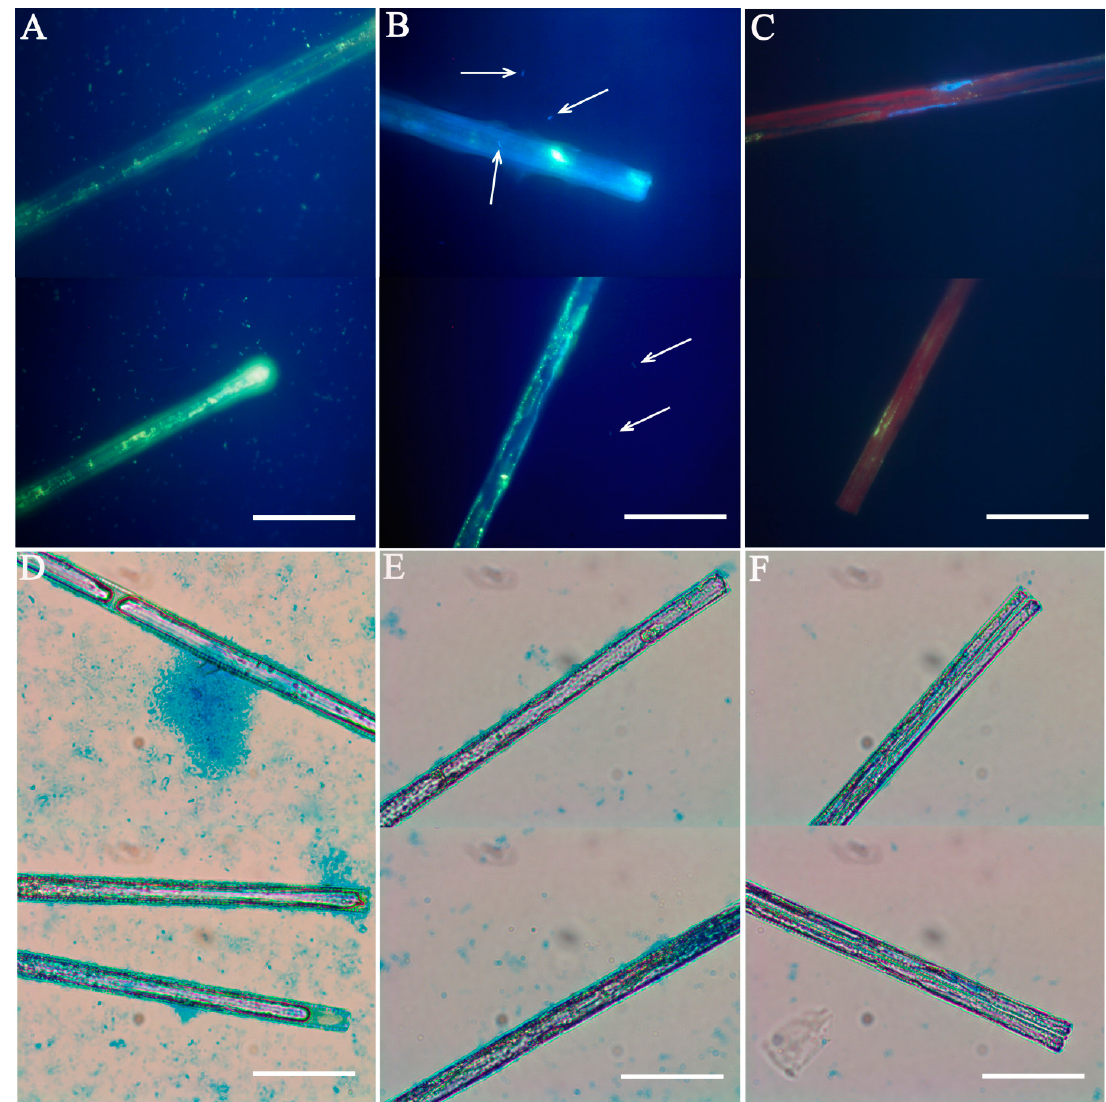
Figure 1. Microscopic validation of diatom Ulnaria danica. ( A – C ) DNA staining: ( A ) xenic culture; ( B ) culture after filtering and washing; ( C ) axenic culture. ( D – F ) extracellular polymeric substance (EPS) staining: ( D ) exponential phase of growth; ( E ) latent phase of growth; ( F ) after washing. Bacteria are marked by arrows. Scale bars: 10 μ m.